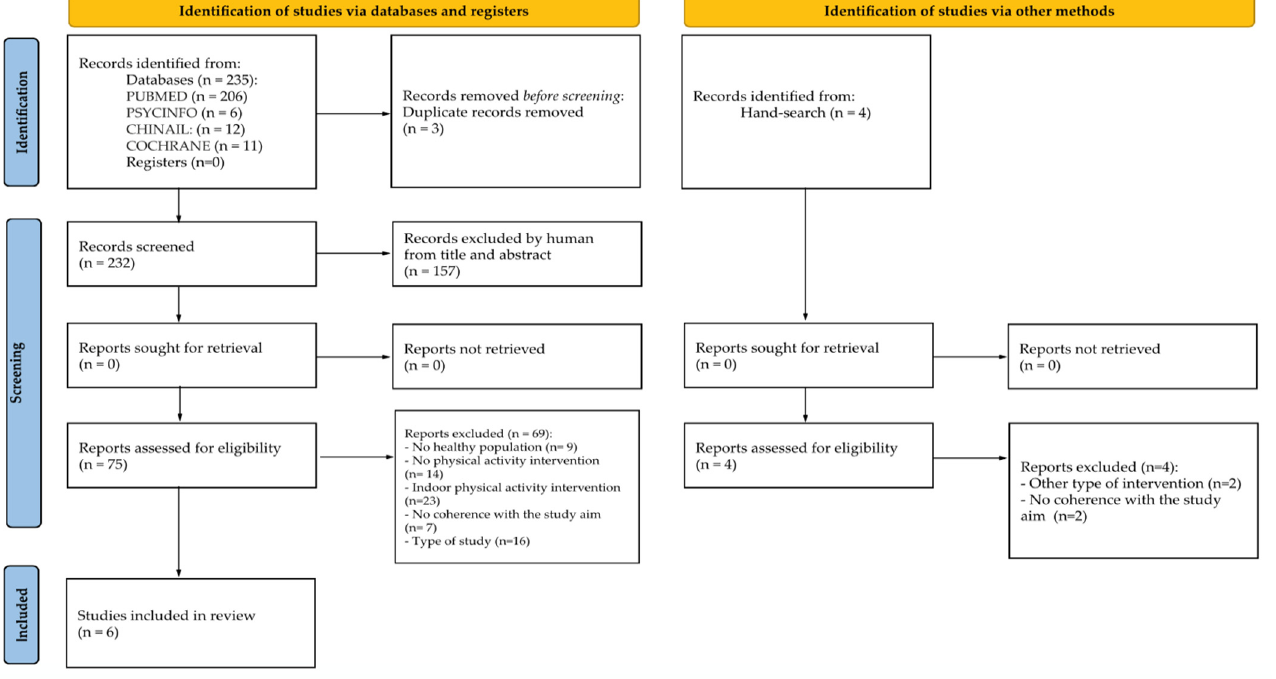
Figure 1. PRISMA 2020 flow diagram of studies selection [31] .